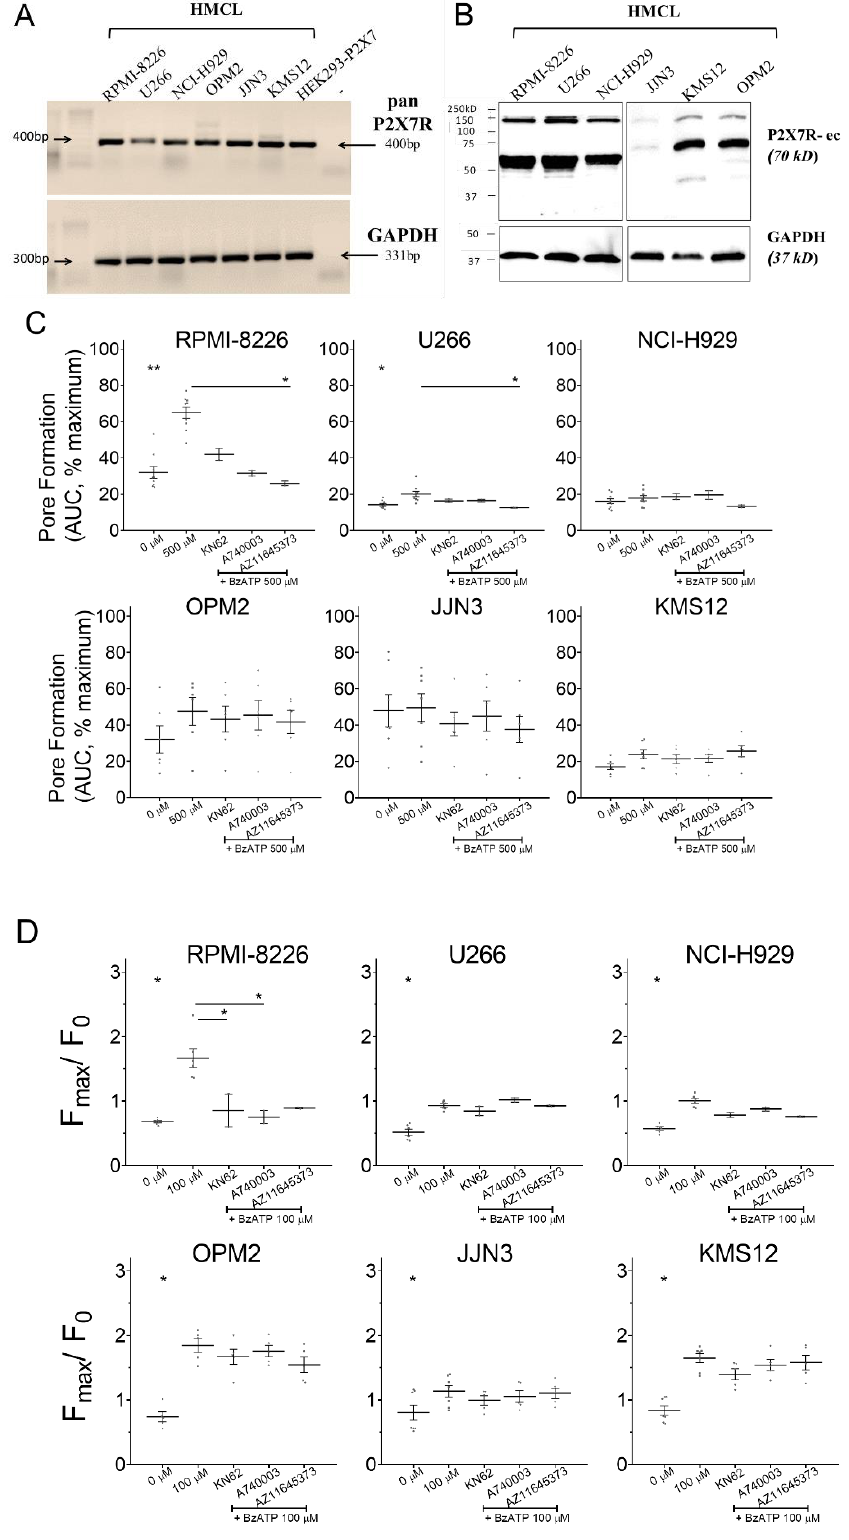
Figure 1. Expression and functionality of P2X7 receptor in RPMI-8226, U266, NCI-H929, OPM2, JJN3, and KMS12 human multiple myeloma cell lines (HMCLs). ( A ) Semi quantitative RT-PCR shows the P2X7 receptor mRNA expression in all HMCLs. Positive control was HEK293 cells stably transfected with P2X7 receptor, negative control (–) was a no template PCR reaction, and GAPDH expression corresponding to the same RT-PCR reaction was used as loading control. ( B ) Whole-cell lysates were immunoblotted with monoclonal antibody P2X7R-ec (raised against the extracellular domain of